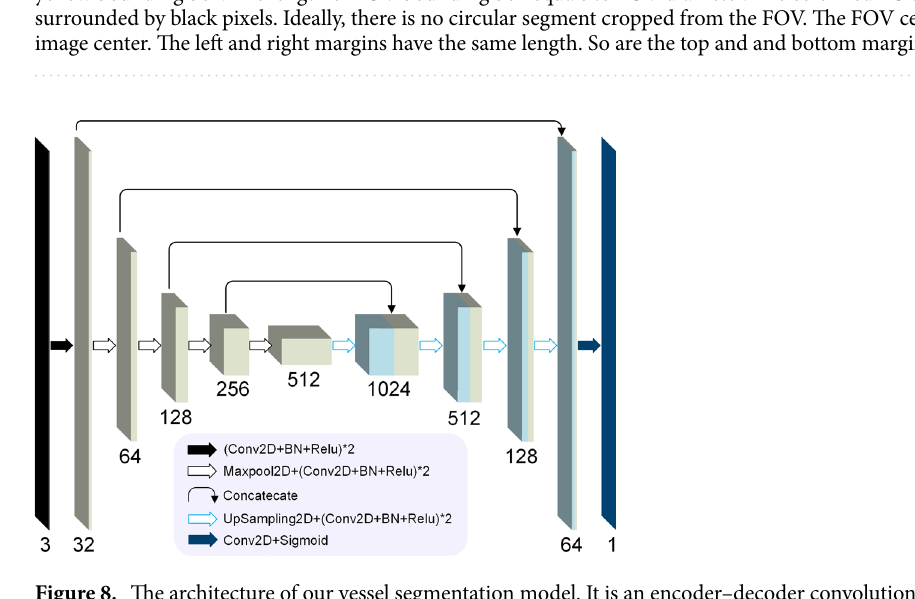
Figure 8. The architecture of our vessel segmentation model. It is an encoder–decoder convolutional neural network. Model input is a 1024 × 1024 color retinal image and model output is single channel 1024 × 1024 vessel prediction image. Conv2D is 2D convolutonal layer with kernel size of (3,3). Padding parameter of Conv2D is set to “same” in order to output the same dimension of the input. BN refers to BatchNormalization layer. Output channels of encoding blocks are 32, 64, 128, 256 and 512 respectively while output channels of decoding blocks are 512, 256, 128, 64 and